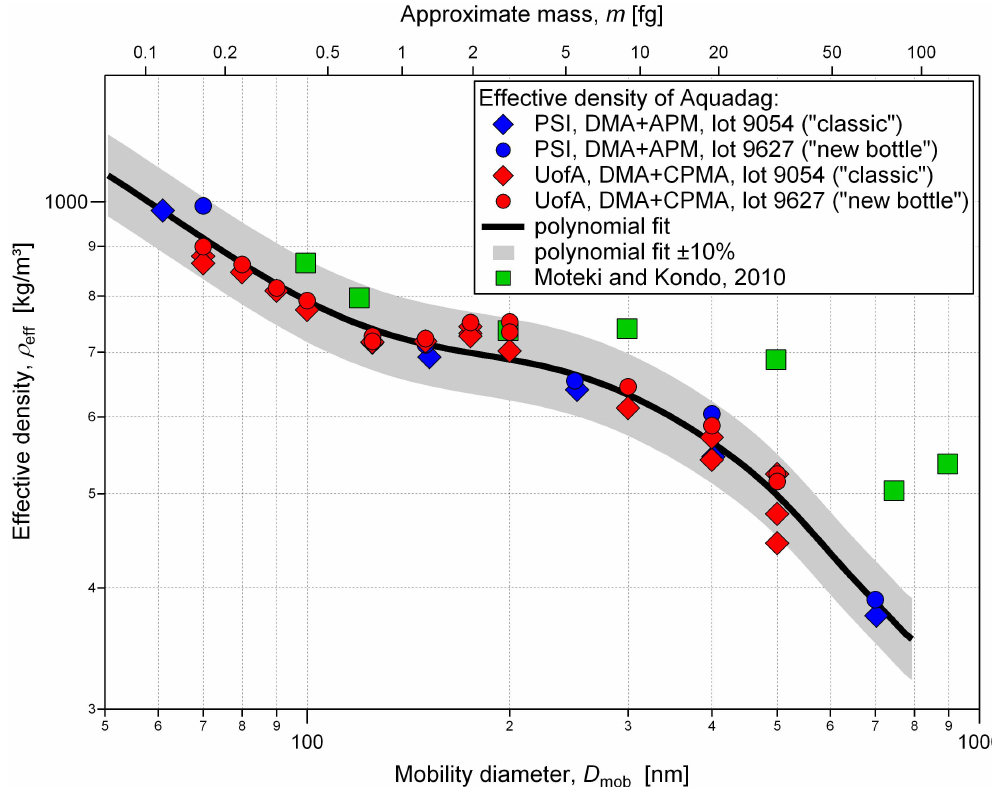
Fig. 3. Effective density of Aquadag as a function of mobility diameter. The approximate mass scale given at the top axis has been calculated from the mobility diameters of the bottom axis using the polynomial